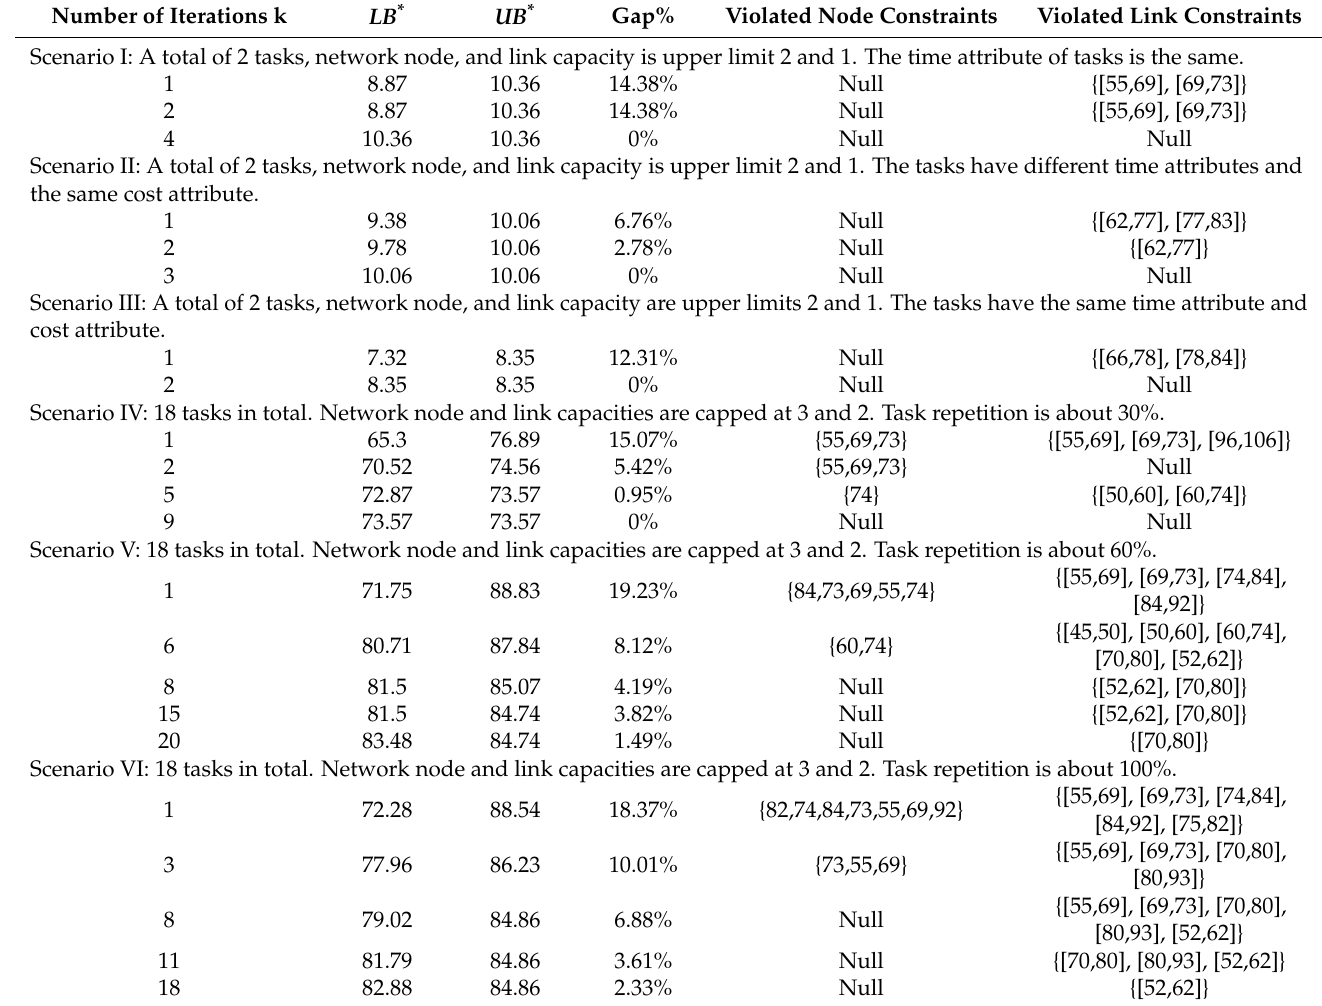
Table 9. Experimental results of illustrative cases.